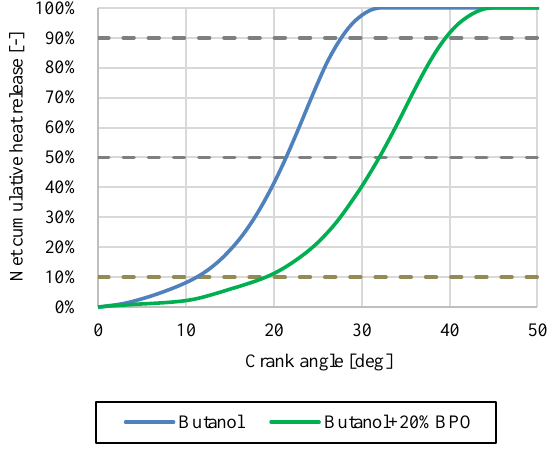
Fig. 16. Net cumulative heat release